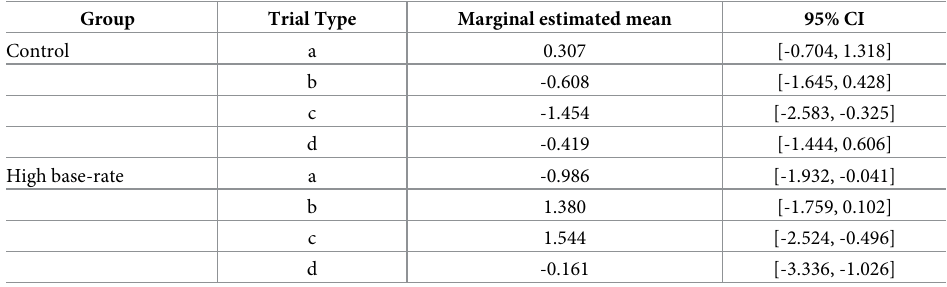
Table 3. Evidential value questions in Experiment 1: Marginal estimated means (logit